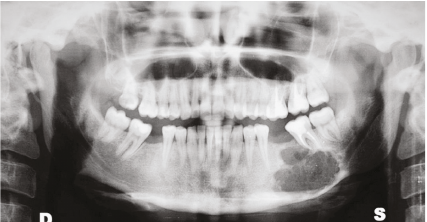
Figure 1: Panoramic X-ray before the excision of ossifying fi